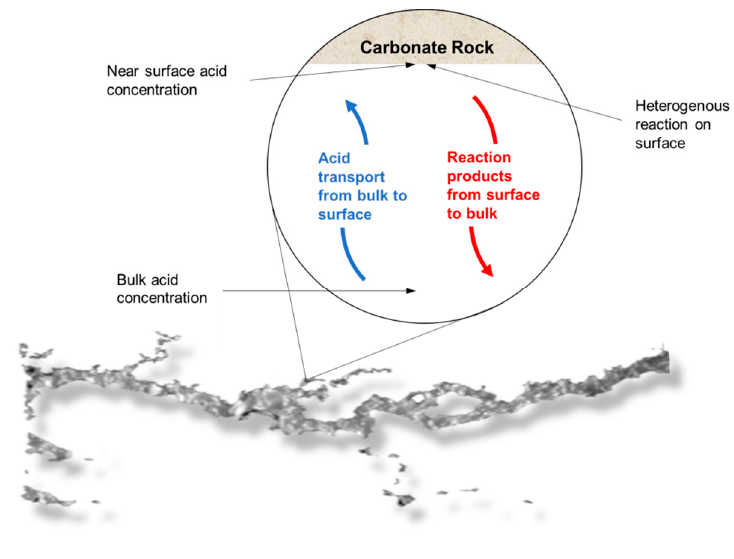
Figure 5. Representation of the heterogeneous reaction mechanism in a wormhole.